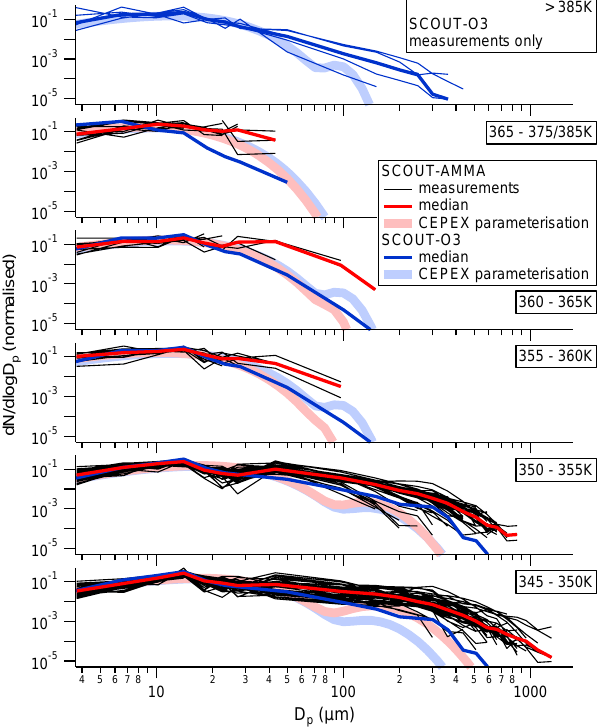
Fig. 1. Normalised ice particle size distributions of the cloud encounters during SCOUT-AMMA (black lines) in West Africa (2006): medians of the in situ measurements are displayed in bright red. The shaded pale red curves result from the CEPEX parameter- isation after McFarquhar and Heymsfield (1997). For comparison M-55 Geophysica data from the Hector MCS in Northern Australia (during the 2005 SCOUT-O3 campaign) are shown with medians in bright blue and a corresponding CEPEX parameterisation in shaded pale blue (from de Reus et al.,